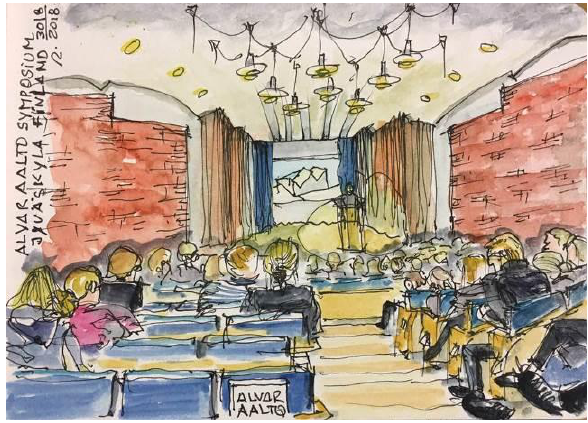
Figure 3. Hand-drawn illustration of Aalto Symposium, provided by student Rui